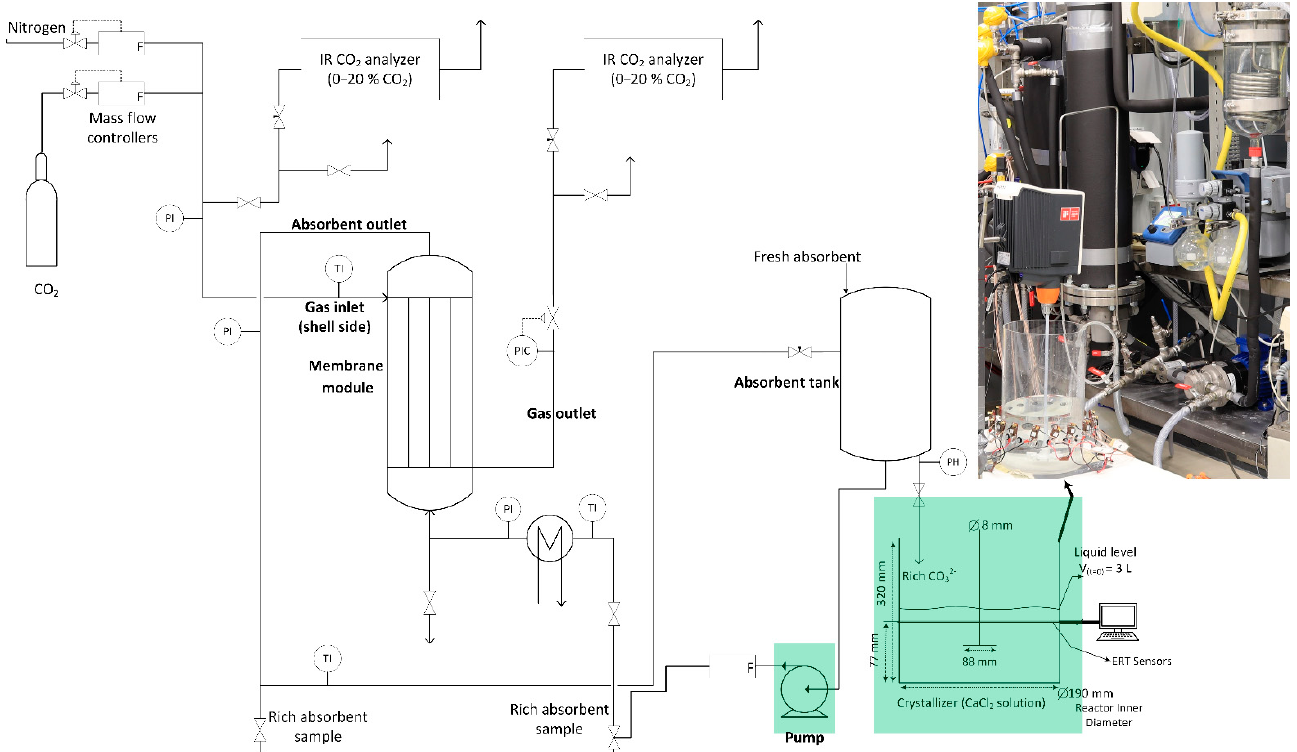
Figure 1. Process schematics: integrated CO 2 capture and calcium carbonate crystallization. A photograph shows the electrical resistance tomography mounted around the crystallizer. Marked with green shows the main components for the FDD analysis.